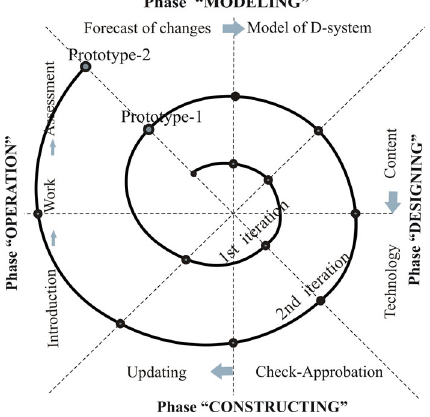
Figure 1. The spiral scheme of D-system